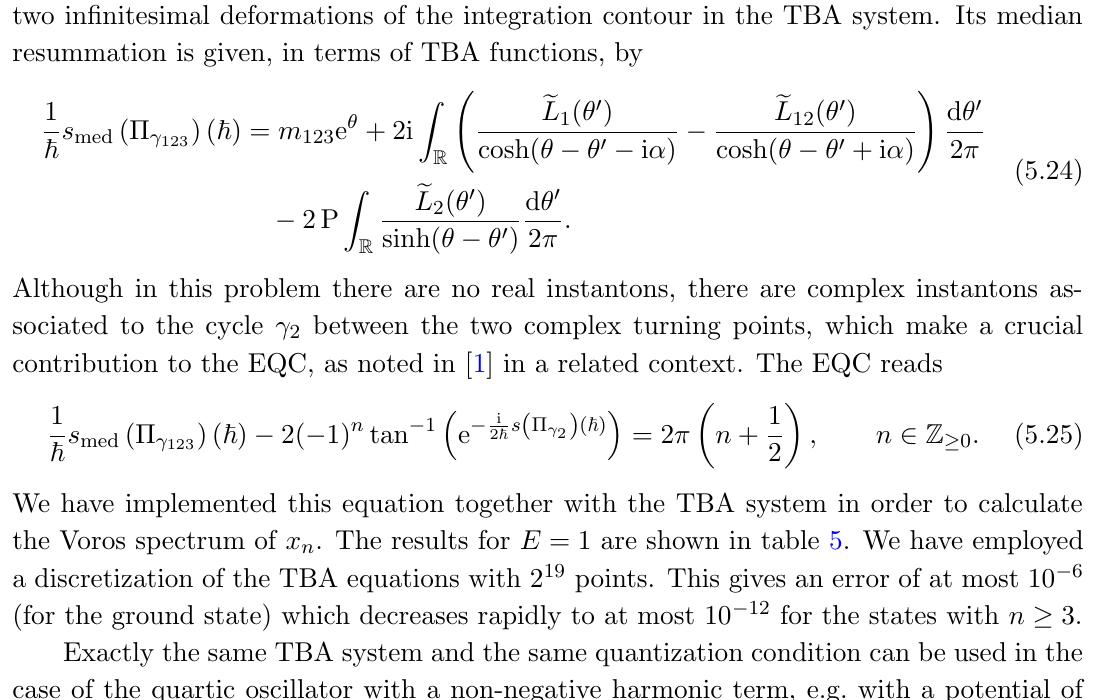
Table 5 . The spectrum of values of x n , as computed from the exact quantization condition (5.25), and the values of E n ( ~ n ) for the Hamiltonian (5.18) with E = 1. under the usual identi(cid:12)cation (cid:18) = log( ~ (cid:0)